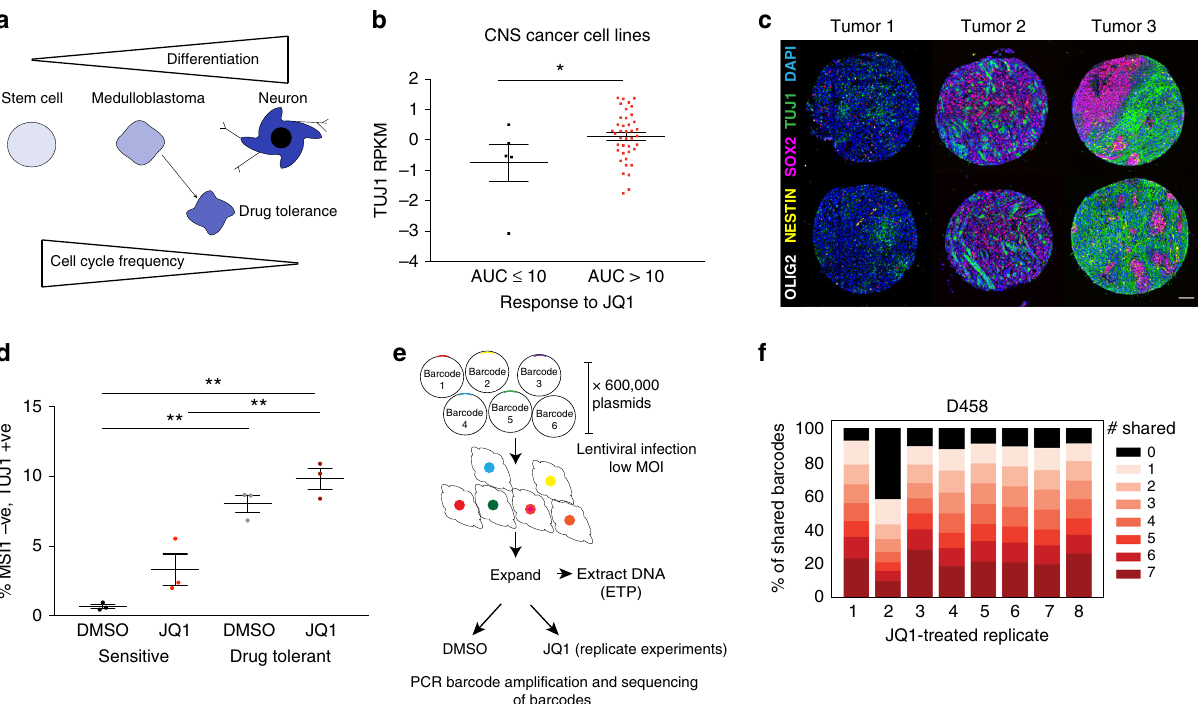
Fig. 10 Drug-tolerant cells exhibit an altered differentiation state that is also present in human medulloblastoma. a Model for altered differentiation in BETi- tolerant medulloblastoma cells. Human medulloblastomas express both stem-cell and neuronal differentiation markers. Following treatment with BETi, drug-tolerant cells exhibit a more neuronal phenotype however do not undergo terminal differentiation, maintaining the ability to progress through the cell- cycle. b Expression levels of TUJ1 (TUBB3) and JQ1 sensitivity of 46 central nervous system cell lines from the CTRP database. AUC denotes area under